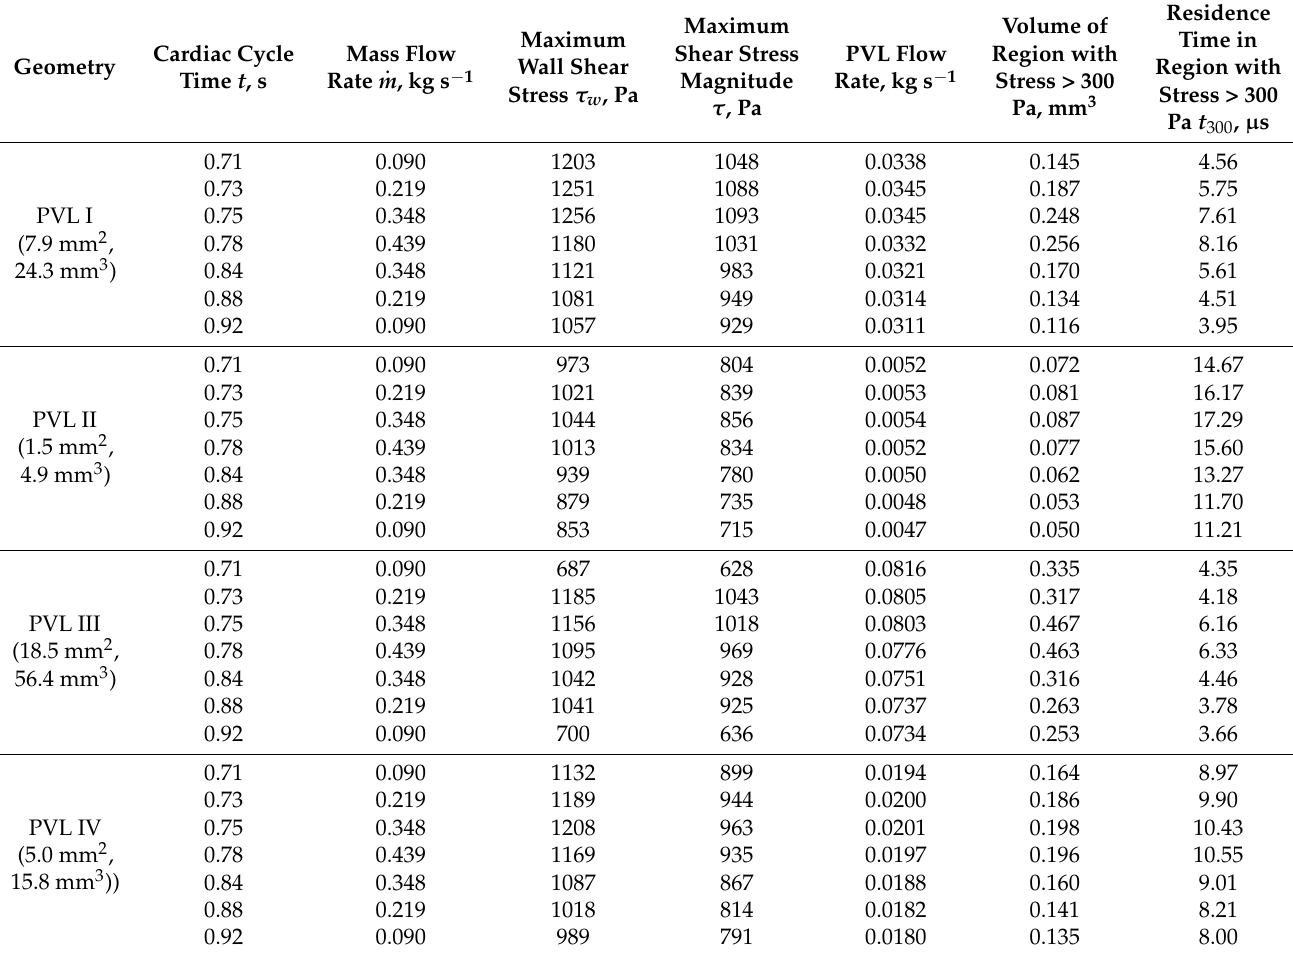
Table A1. Data used to prepare